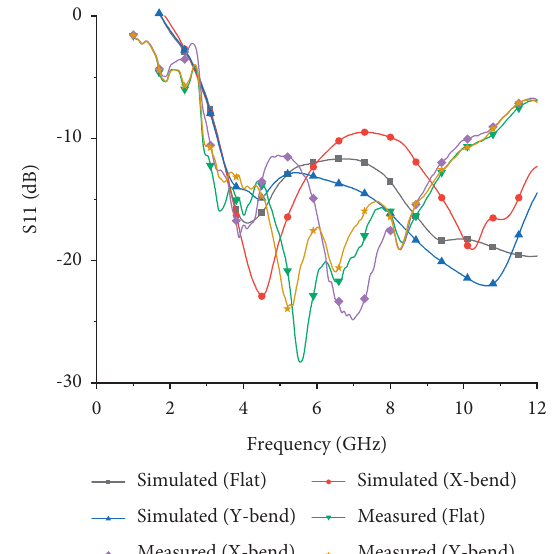
Figure 13: Comparison of the characteristics of the simulation and measurement of reflection coefficients caused by structural deformation on the human